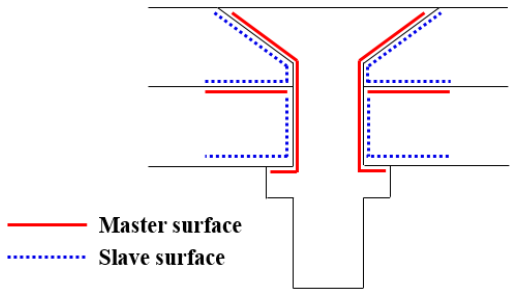
Figure 12. Master and slave surfaces in each contact pair.